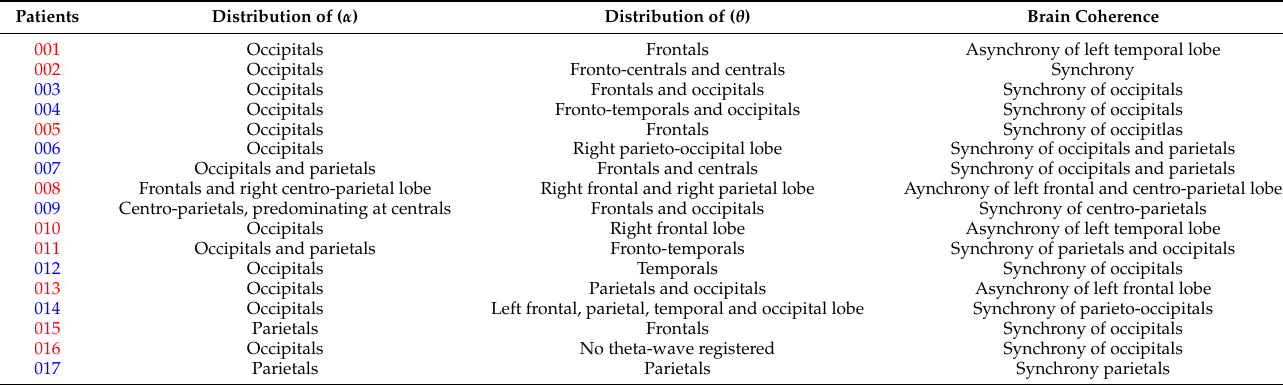
Red represents patients who used filters transmitting long-wavelength light (red-orange-yellow) and blue the patients who used filters transmitting low-wavelength light (from bright to dark blue and the combination of grey-blue and violet-blue). Filters transmitting medium-wavelength light (green) are stabilizing filters and were combined either with red or blue filters according to the needs of each patient. EEG recordings were carried-out in the waking-state. ( α ), alpha-wave; ( θ ),